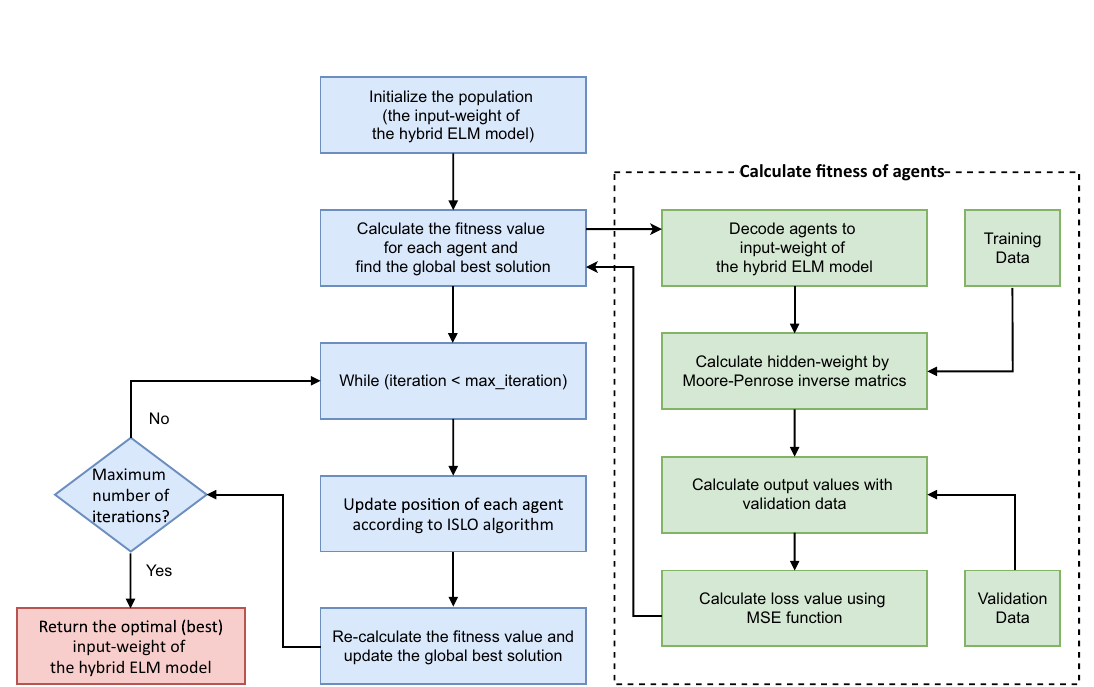
Fig. 2 ELM architecture and encoding process